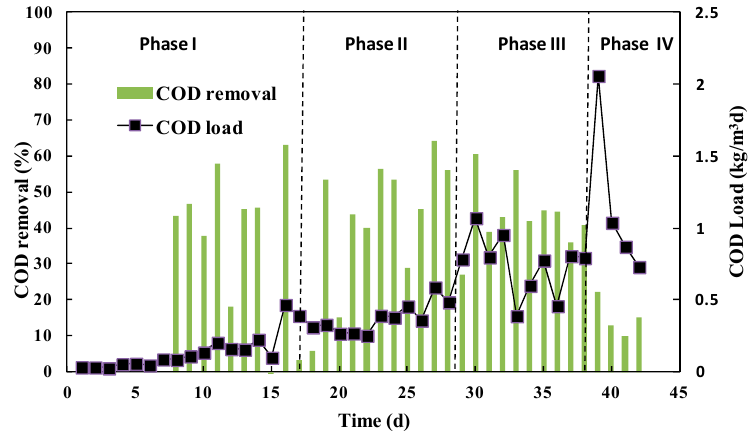
Figure 2. Effects of the organic loading rate (OLR) on the COD removal (based on TCOD) of the hydrolysis reactor.